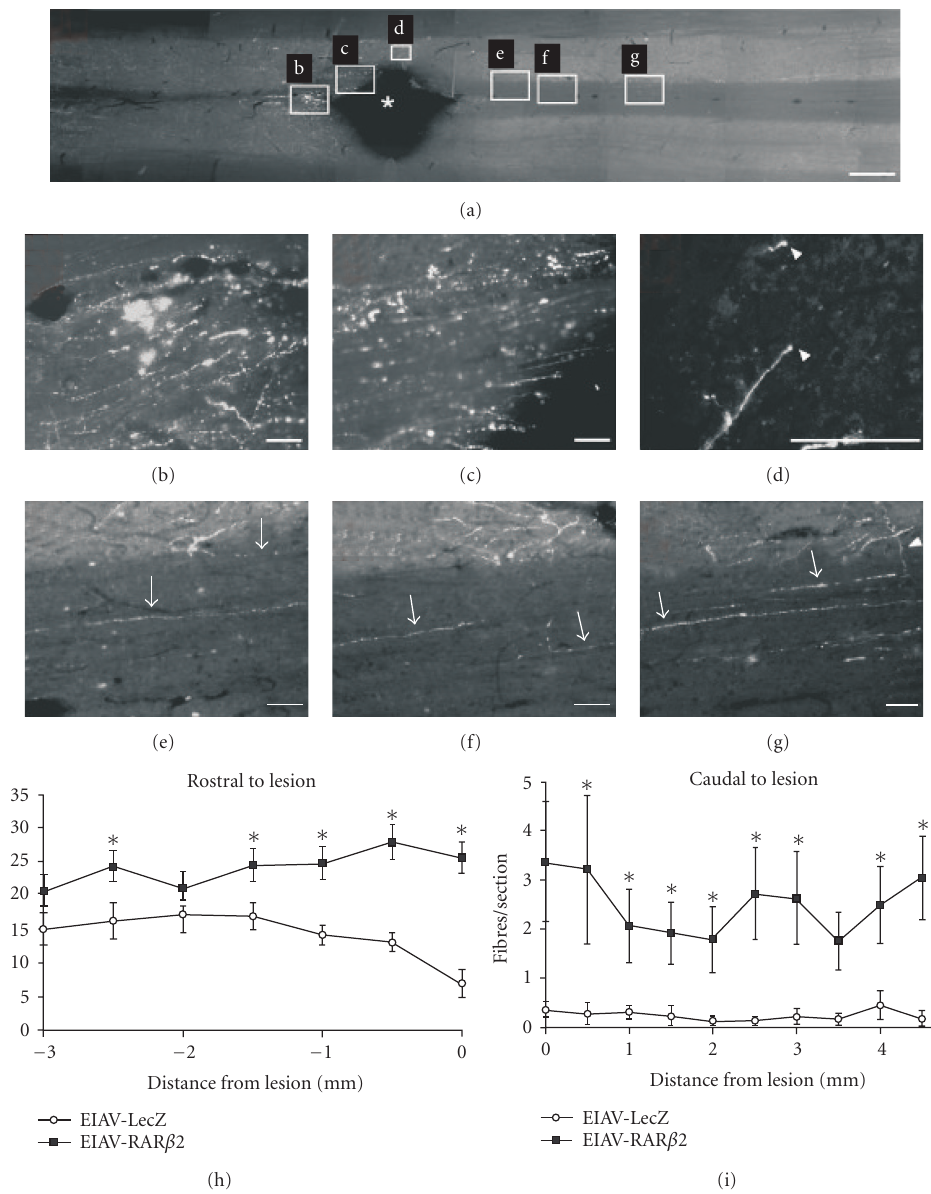
Figure 4: Transfection of RAR β induces regeneration of corticospinal axons in vivo. (a) Longitudinal sections of the adult rat spinal cord were traced with BDA to determine fibre regeneration in the corticospinal tract; overview of the lesion site in an animal injected with the RAR β 2 expressing construct (EIAV-RAR β 2, Rostral: left). (b) Animals with RAR β 2-transfected cells displayed less fiber degeneration than control rats. (c) Labeled axons were detected up to the edge of the lesion, (d) at the distal edge of the lesion, and (e—g) at various distances caudal to the lesion. Growth cone-like endings were detected at the tips of some axons (white arrowheads in d). Axons appear to send collaterals (white arrowhead in g) from white matter to grey matter. (Scale bars in (a): 1mm, in (b—g): 100 μm .) (h—i) Quantification of BDA-labeled fibres in the corticospinal tract after spinal cord lesion. EIAV-RAR β 2-treated animals displayed increased fiber numbers rostral and caudal to the lesion compared to control animals ( P < . 05, two-way ANOVA) (source: